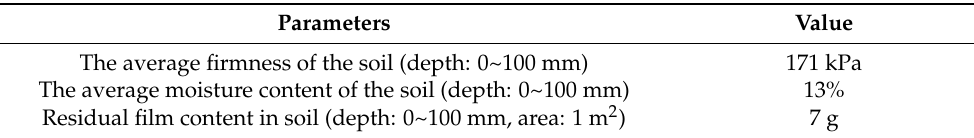
Table 2. The parameter settings of the test field. Parameters Value The average firmness of the soil (depth: 0~100 mm) 171 kPa The average moisture content of the soil (depth: 0~100 mm) 13% Residual film content in soil (depth: 0~100 mm, area: 1 m 2 ) 7